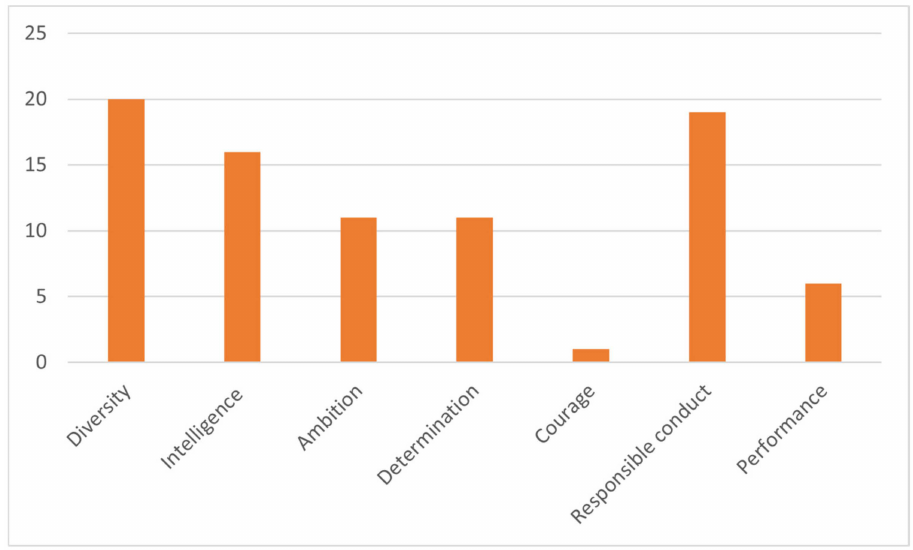
Figure 2. Distribution of specifications for the “profile of the athlete”